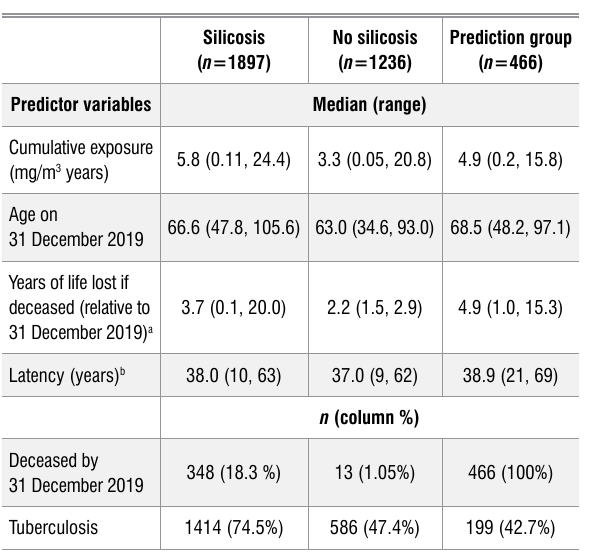
a Modelling group: n =348 and n =13 with and without silicosis, respectively. b Modelling group: n =1886 and n =1225 with and without silicosis, respectively (22 missing); Prediction group: n =456 (10 missing).